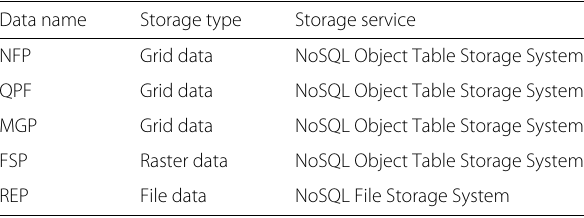
Table 2 The set of experimental data